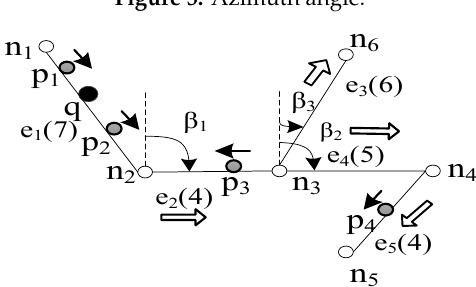
Figure 5. Azimuth angle.